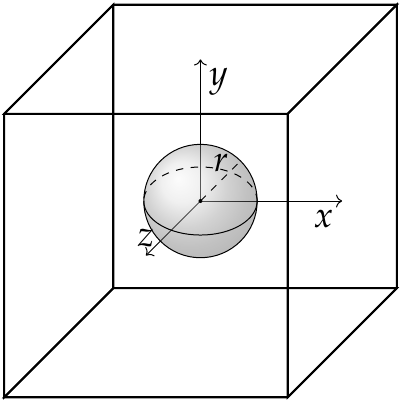
Figure 6. Cube with a spherical hole.